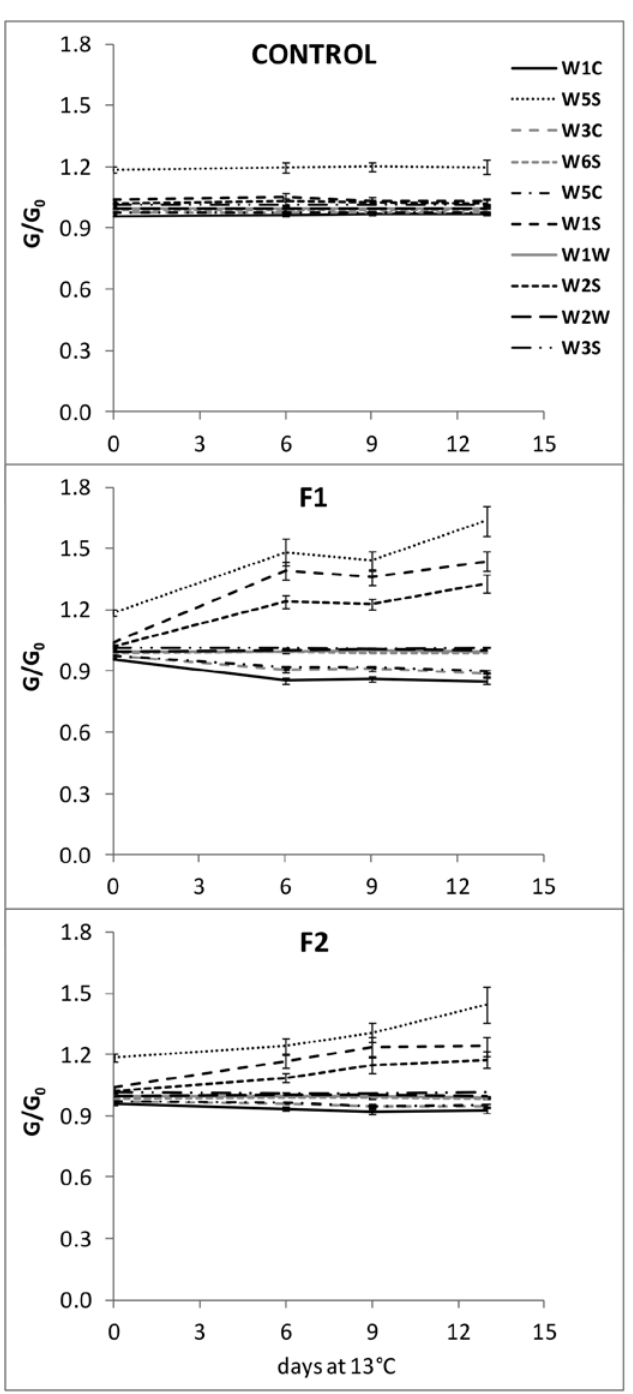
Fig. 6 - PCA scores of PC1 and PC2 according to coating treatment Fig. 4 - Relative conductivity (G/G ) of each sensor in control and coat- (control; coated=F1, F2) and days at 13°C (d0, d6, d9, d13 re- 0 ed (F1, F2) melon fruit during storage at 13°C. Bars refer to fers to arrival, after 6, 9 and 13 days at 13°C, respectively). Bars standard error of the mean (n=6). refer to standard error of the mean